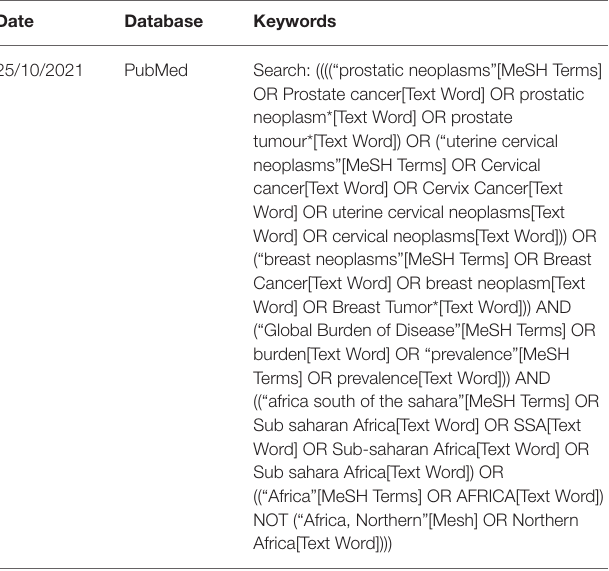
TABLE 2 | PubMed pilot search strategy for SSA studies on cervical, breast and prostate